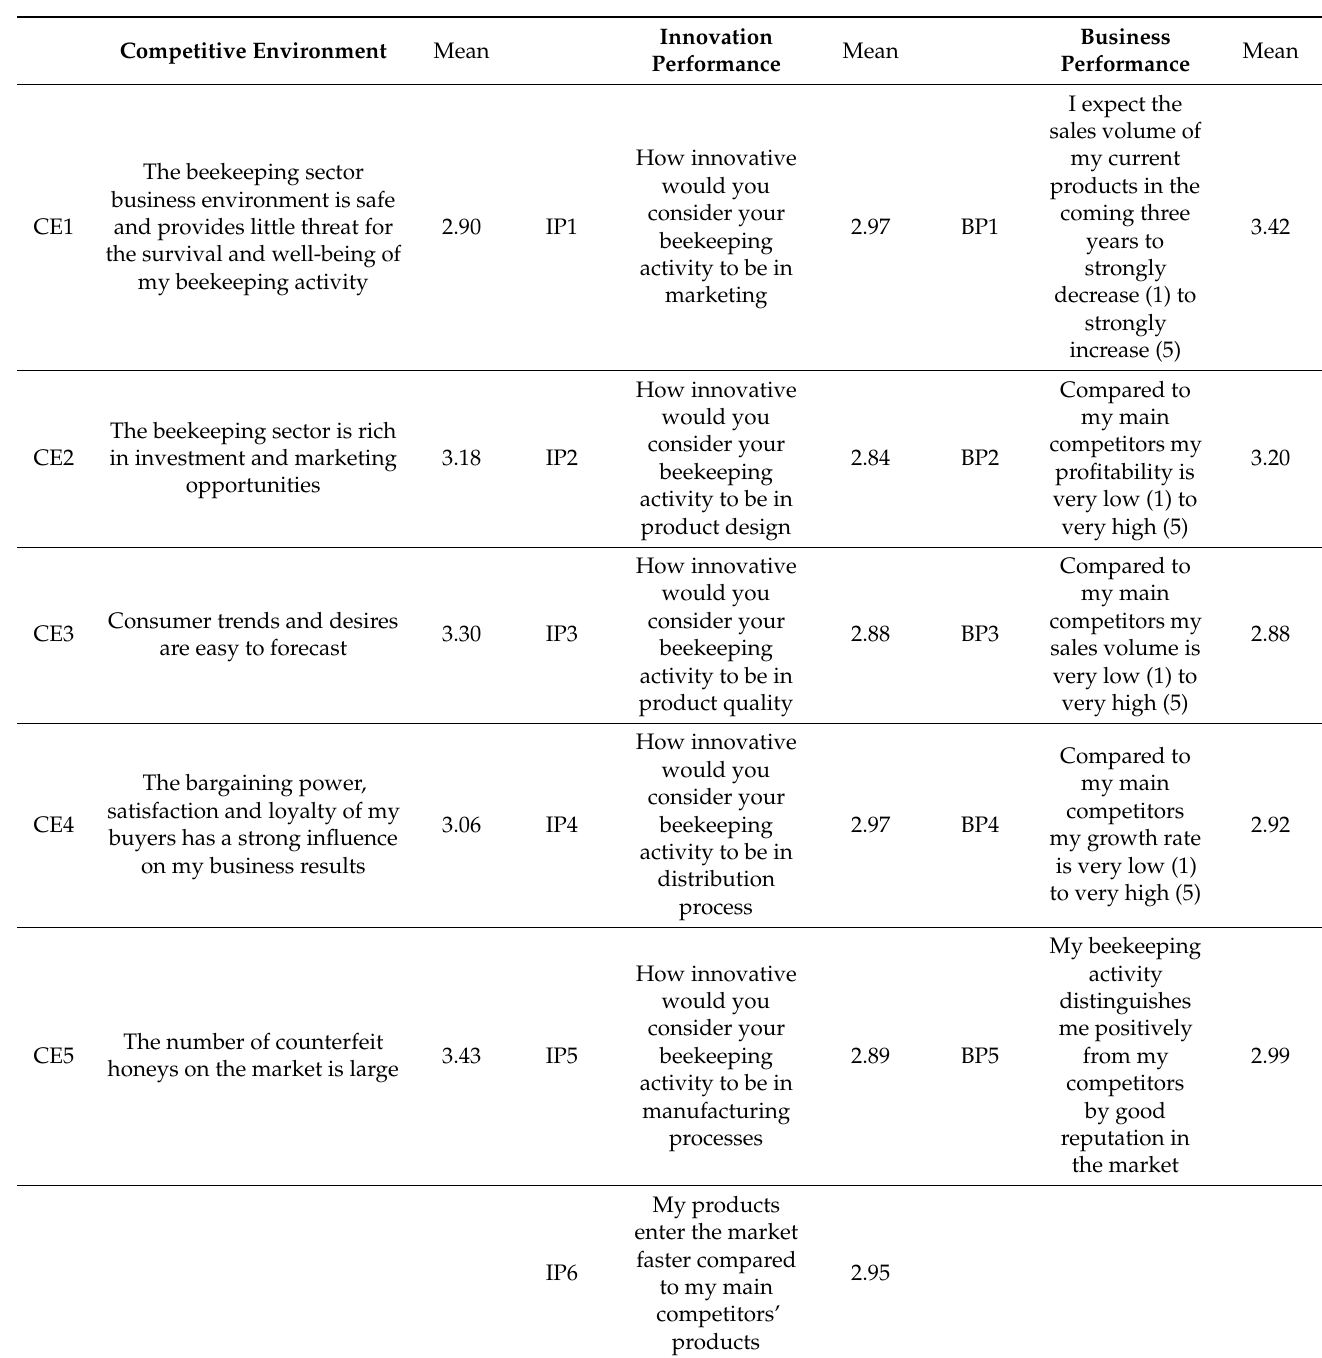
Table 2. Perceived characteristics of the competitive environment, innovation performance and business